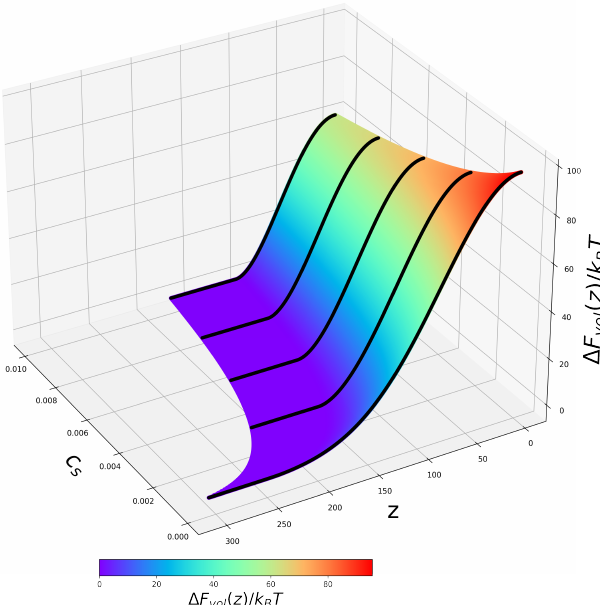
Figure 5. 2D profiles of the osmotic contribution ∆ F vol ( z , C s ) to the free energy of the BSA globule in the PE brush plotted according to Equation